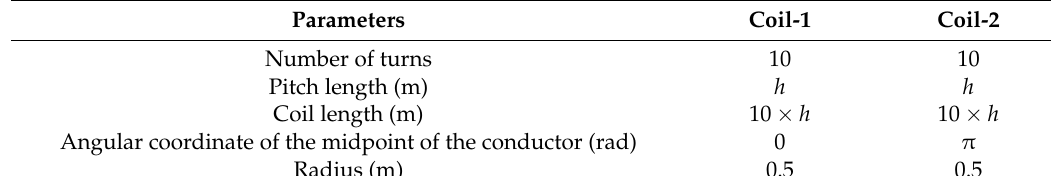
Table 4. Geometric parameters of the coils in Figure 2 (3rd comparison).